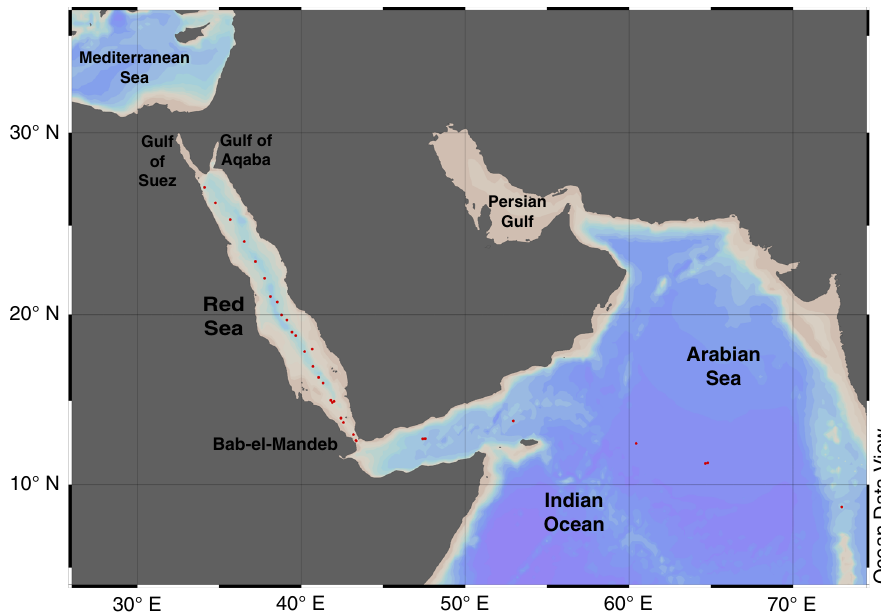
Fig. 1 Location map of surface water samples collected for the present study. The map was created using Ocean Data View 5.0 79 . Supplementary Table 1 provides details of the exact sampling locations and times, and the physical and chemical parameters measured for the present work